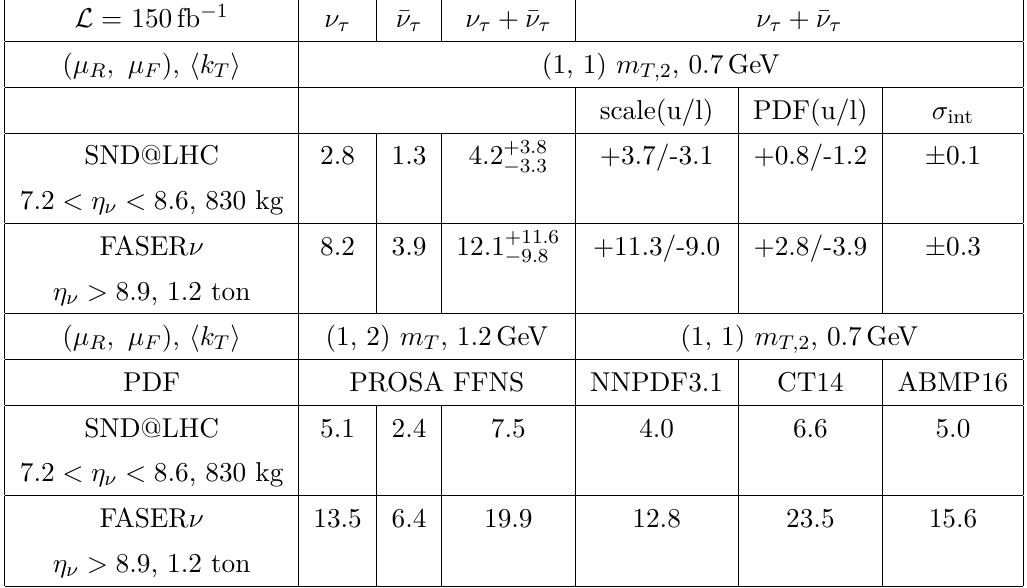
Table 3. The numbers of events induced in the FASER ν (1.2 tons of tungsten, η ν > 8 . 9 ) and